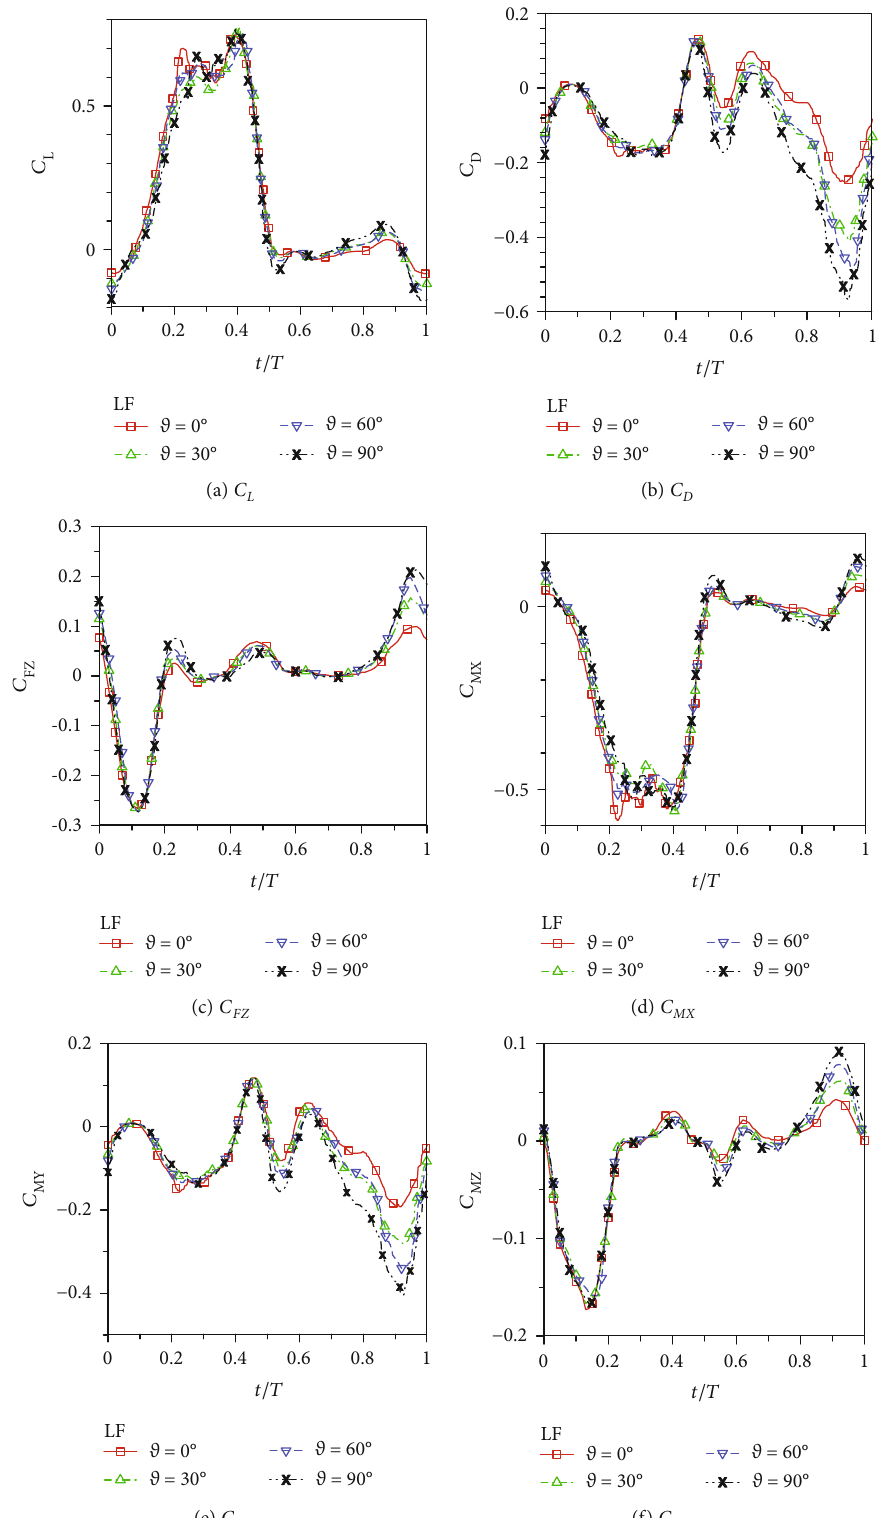
Figure 6: Coe ffi cients of instantaneous aerodynamic force and moment vs ϑ